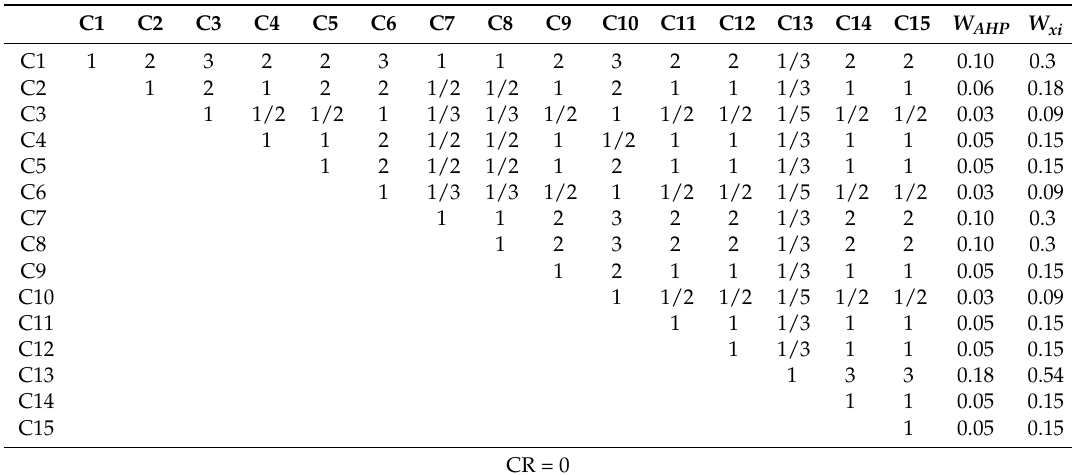
Table 6. The weights estimated from the analytical hierarchy process model and the final weights for the indicators of the capacity and measure factor. For the definition of C1, C2 . . . C15, see Table